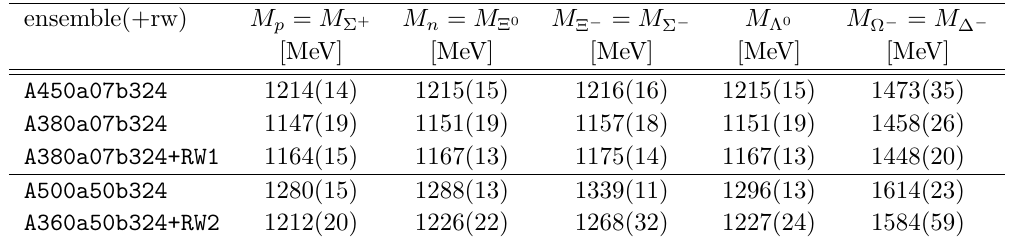
Table 7 . For each ensemble (possibly with mass reweighting): baryon masses. Values in MeV are obtained by using the reference value (8 t 0 ) 1 / 2 = 0 . 415 fm [51]. Notice that some baryons are degenerate because in our simulations m d = m s